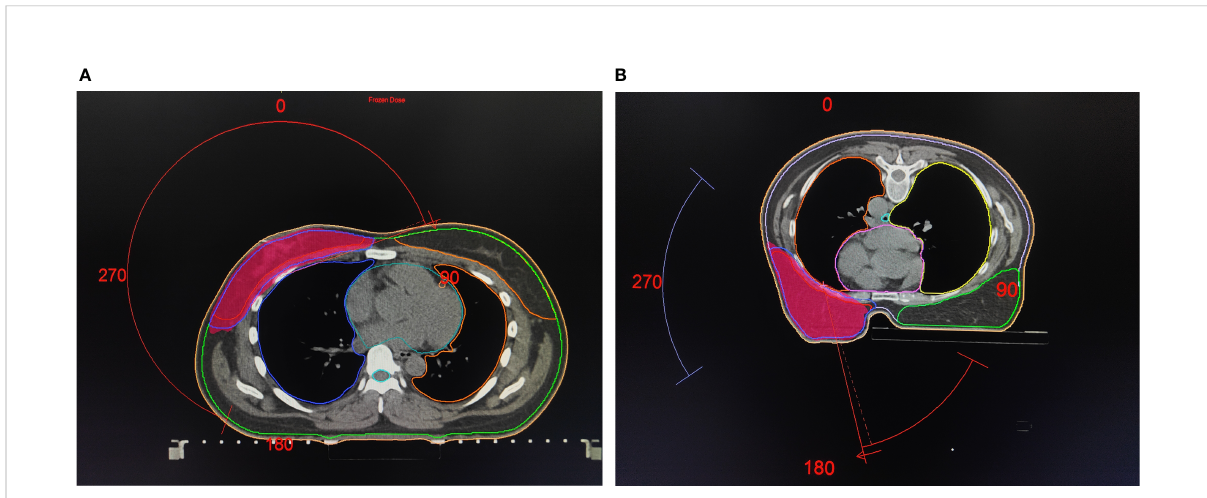
FIGURE 2 Supine/Prone treatment plans with target and organs at risk delineation. (A) Treatment plans of the supine position. (B) Treatment plans of the prone